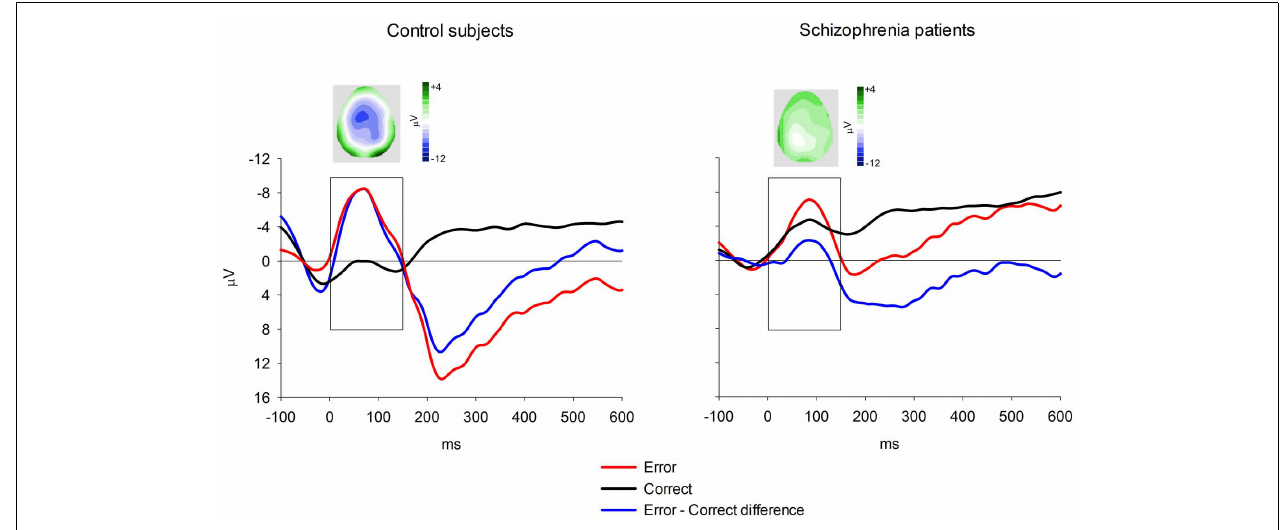
FIGURE 5 | Response-locked ERN group averages for the flanker task. Data shown in waveforms are from FCz.Topographical maps depict distribution of difference wave at latency of peak negativity.The scoring window for the difference waves is indicated by the